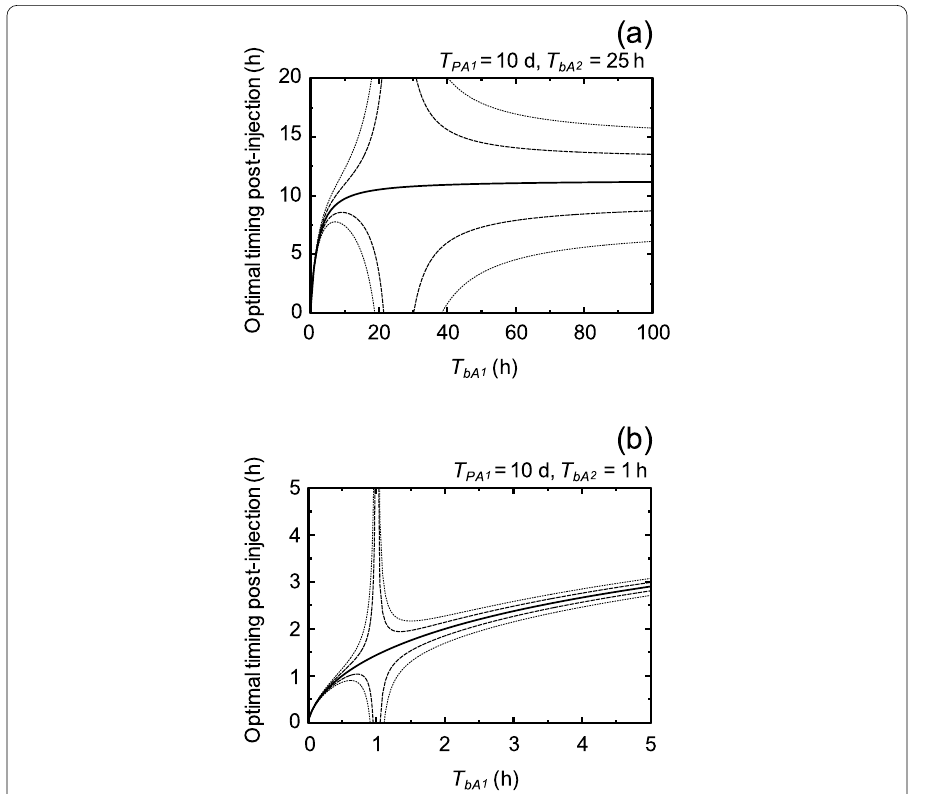
Fig. 5 Behavior maps of an optimal timing (solid line) on radiolabeled target compounds with a physical HL of 10 d. T pA1 and T bA 1 are the physical HL and HL of the biological clearance of a target, respectively. a HL of the biological clearance of a reference,